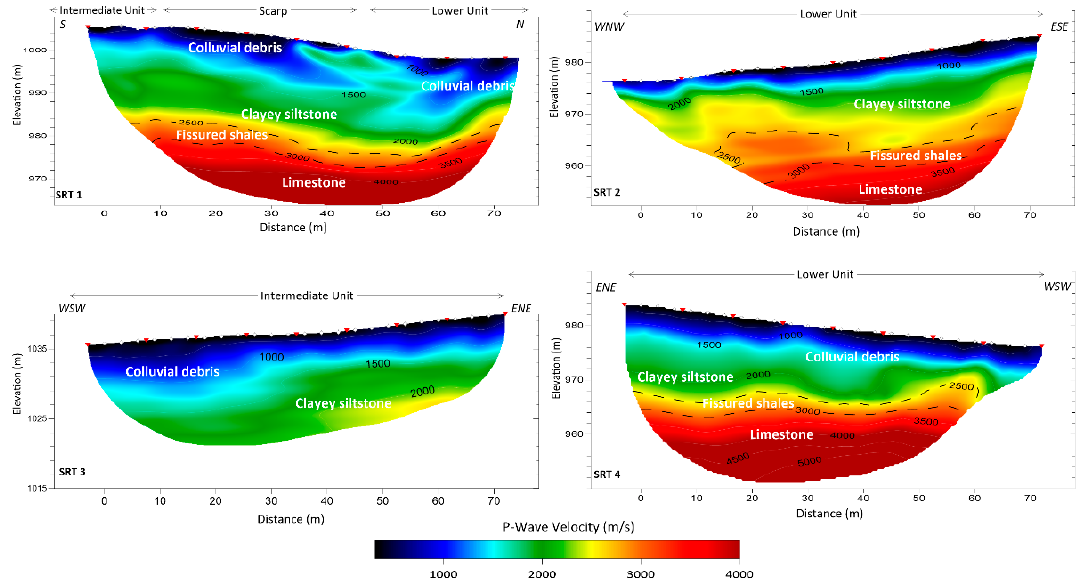
Figure 5. Inverted seismic refraction tomography pseudo-sections with the corresponding interpre- tation.